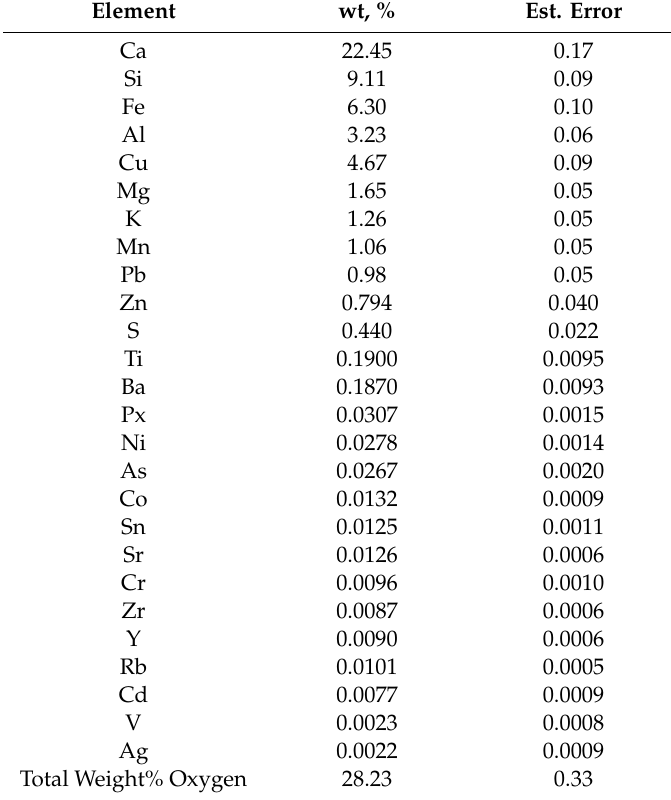
Elementary chemical composition obtained by X-ray fluorescence from the mining waste